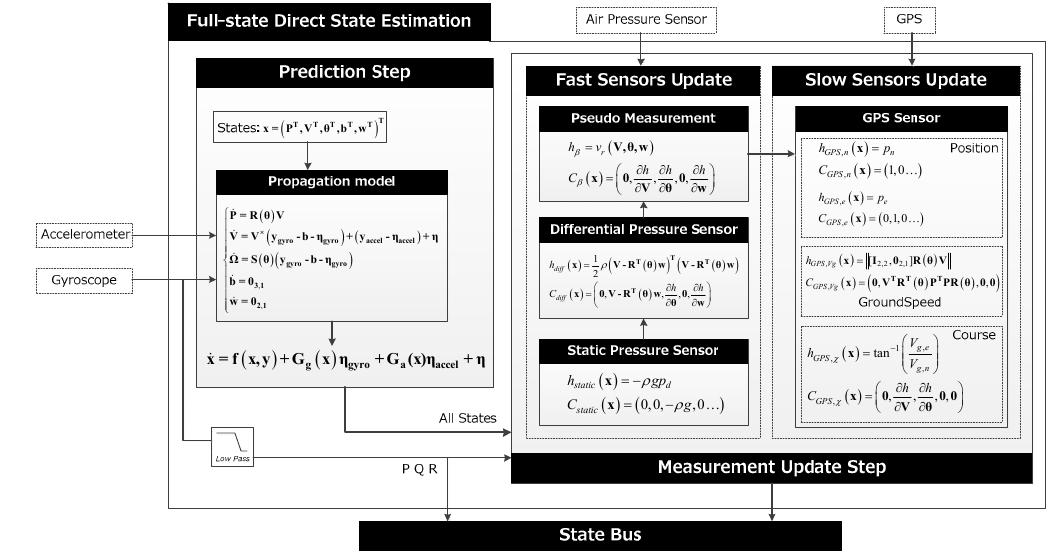
Figure 8. Full ‐ state direct state estimation structure. Figure 8. Full-state direct state estimation